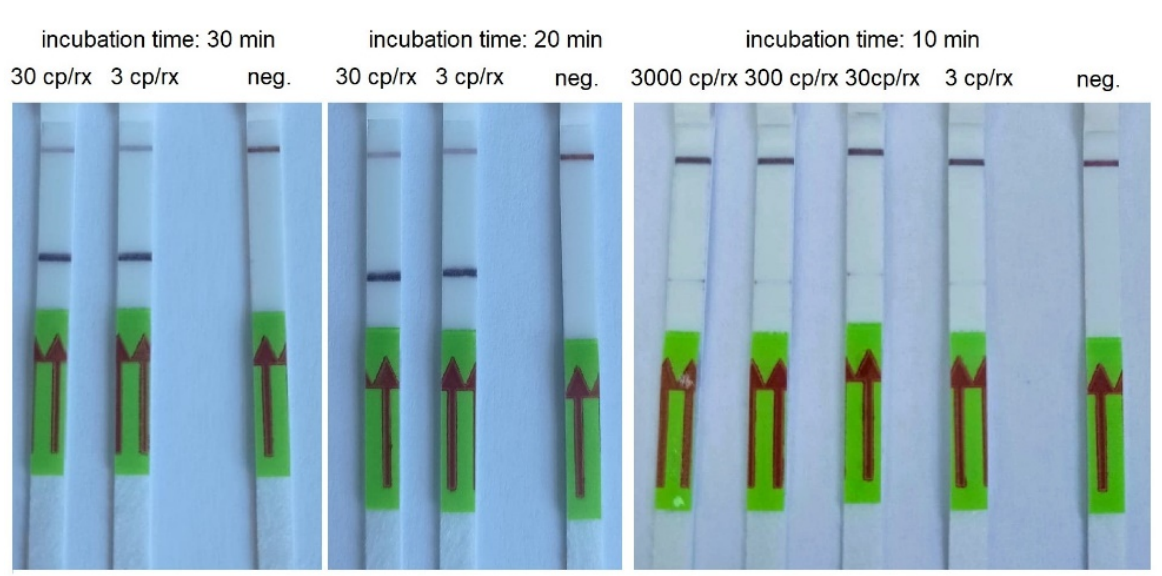
Figure 4. An example of RT-HDA combined with LFA performed using serial dilutions of AMPLIRUN SARS-CoV-2 RNA control and various incubation times. cp/rx—copies/reactions; neg.—negative